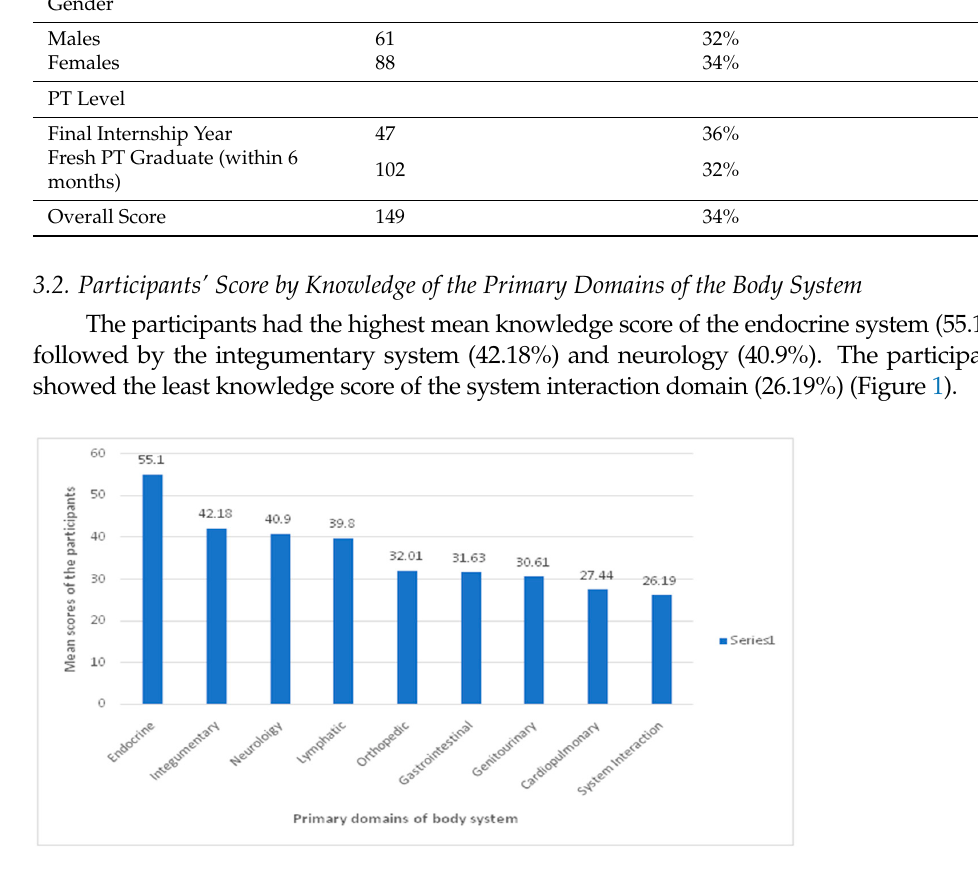
Figure 2. Mean knowledge score of participants in different non-system domains. 3.4. Scores of Participants Based on Different Categories of Patient Management The participants obtained the highest mean knowledge score in the field of assess- ment (38.57%), followed by screening (36.95%), and lowest in the intervention (34.79%) (Figure 3). Figure 3. Mean knowledge score of participants in different categories.